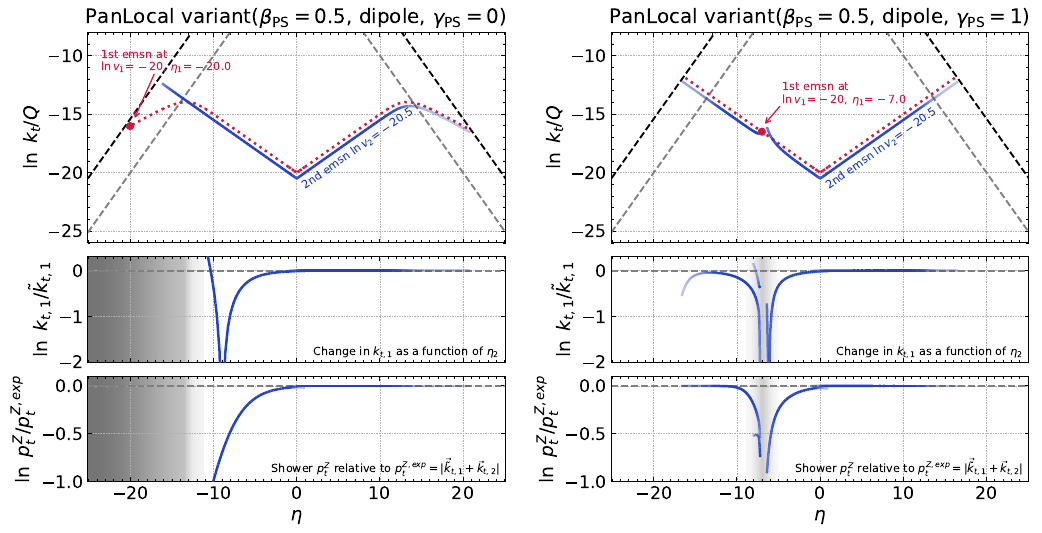
Figure 5. As in figure 2, showing non-default PanLocal variants with (left) the choice b k = β k (corresponding to γ = 0 in eq. (4.17)) and (right) the choice γ = 1 . with k & k . In practice the region α (cid:29) 1 is suppressed by the PDF ratio in eq. t 2 t 1 k 1